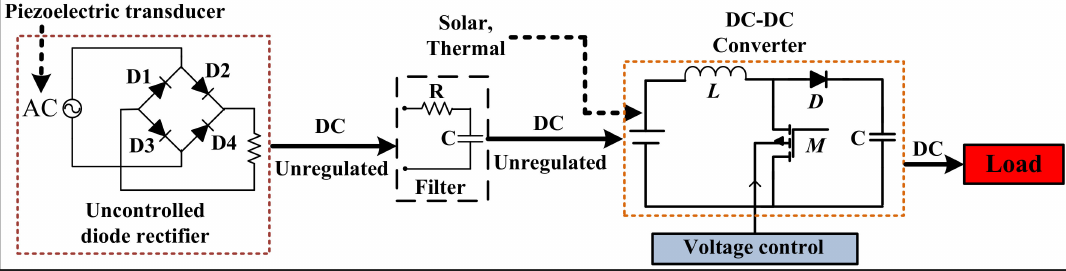
Figure 2. A conventional schematic diagram of PEHS